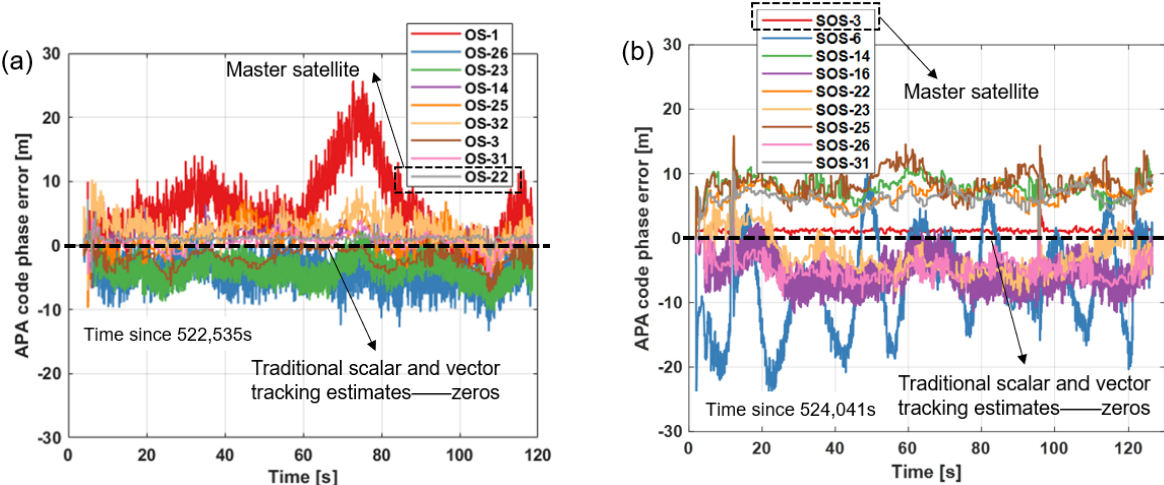
Figure 18. APA code phase errors from the proposed RTK/INS-based VDFPLL SDR where the numbers correspond to the satellite PRN numbers and dashed black lines correspond to the estimates from the traditional scalar and vector tracking algorithms ( a ) open sky ( b ) semi-open